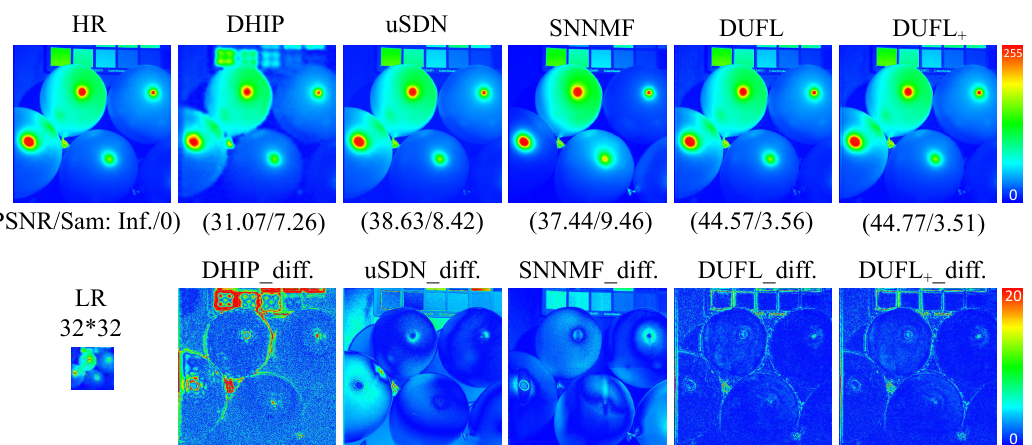
Figure 3. Recovered HR-HS image of the (cid:48) Balloon (cid:48) sample in the CAVE dataset using the DHIP [24], uSDN [41], SNNMF [51], and the proposed methods and corresponding difference images between the ground-truth and recovered images with an upscale factor of 8.